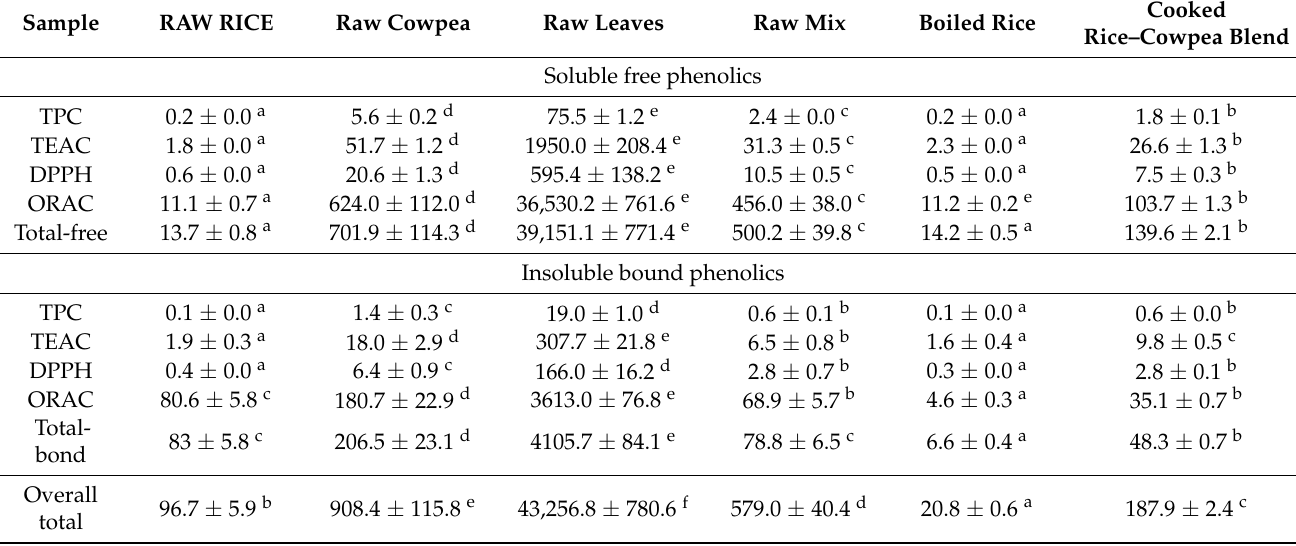
Table 4. Total phenolic content and antioxidant activities of raw white rice, cowpea, sorghum leaves, their composite blend, and cooked